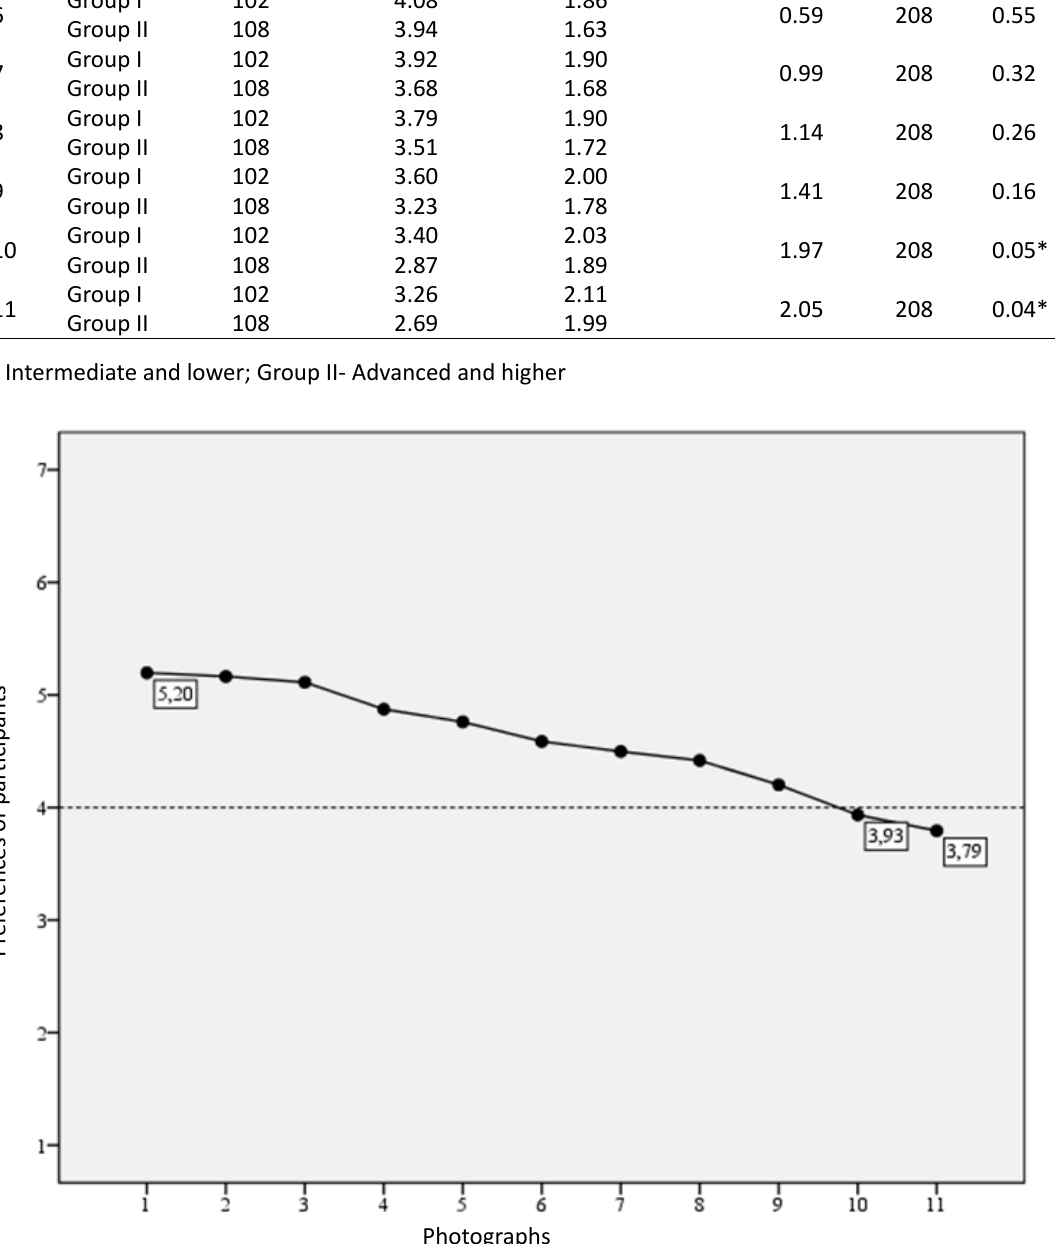
Figure 3. Participant climbing willingness curve on the basis of photographs (Chalk density effect)